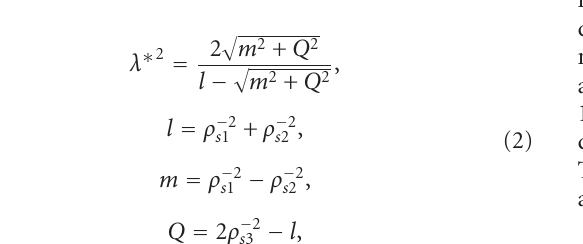
3.2.2. Apparent Resistivity Anisotropy Coe ffi cient